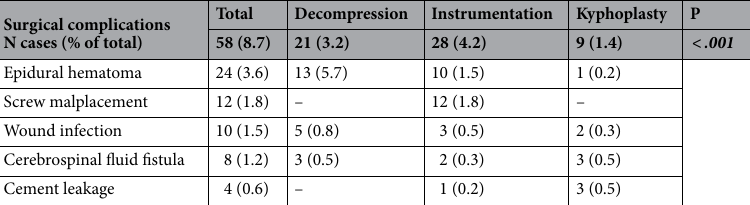
Surgical complications N cases (% of total)